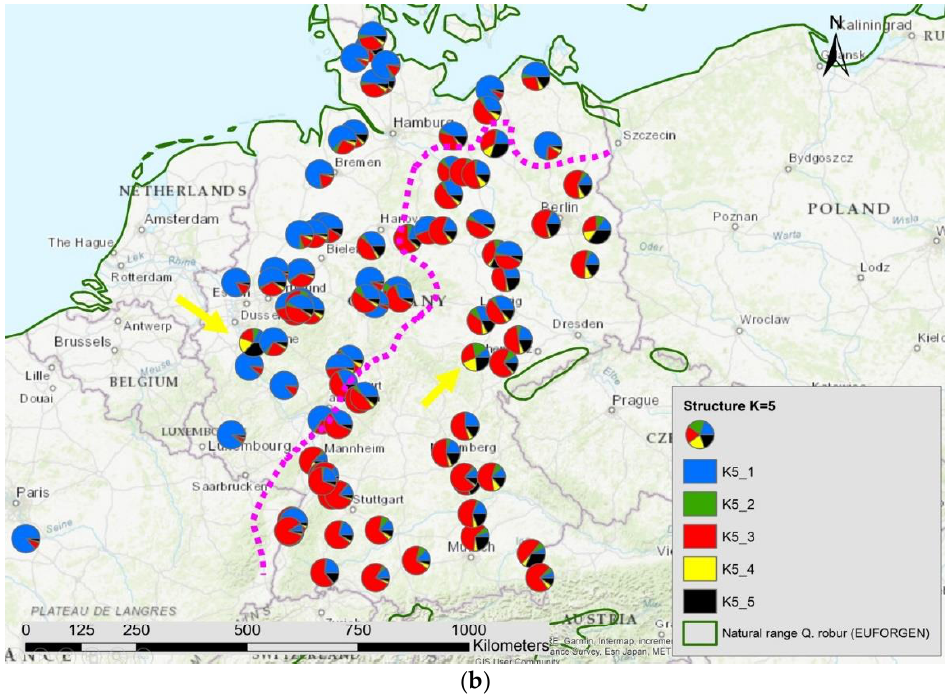
Figure 7. Spatial distribution of ( a ) haplotypes and ( b ) the results of STRUCTURE K = 5 in Germany; the pink dotted line indicates the contact zone of different haplotypes and nuclear gene pools; the yellow arrows point to two locations with manmade gene flow.